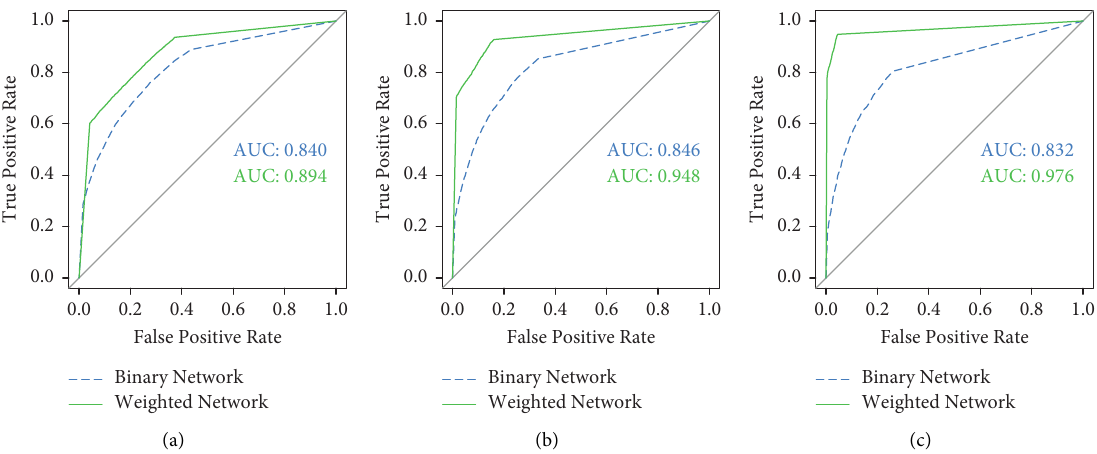
Figure 5: Receiver operating characteristics (ROC) curves comparing the valued ERGM model with binary ERGM models with different cutoff values for network binarization on the 2014 car competition network. We observe that irrespective of what cutoff value is used, valued ERGM models have higher precision and recall values than other models: (a) cutoff � 1.0, (b) cutoff � 2.0, and (c) cutoff �